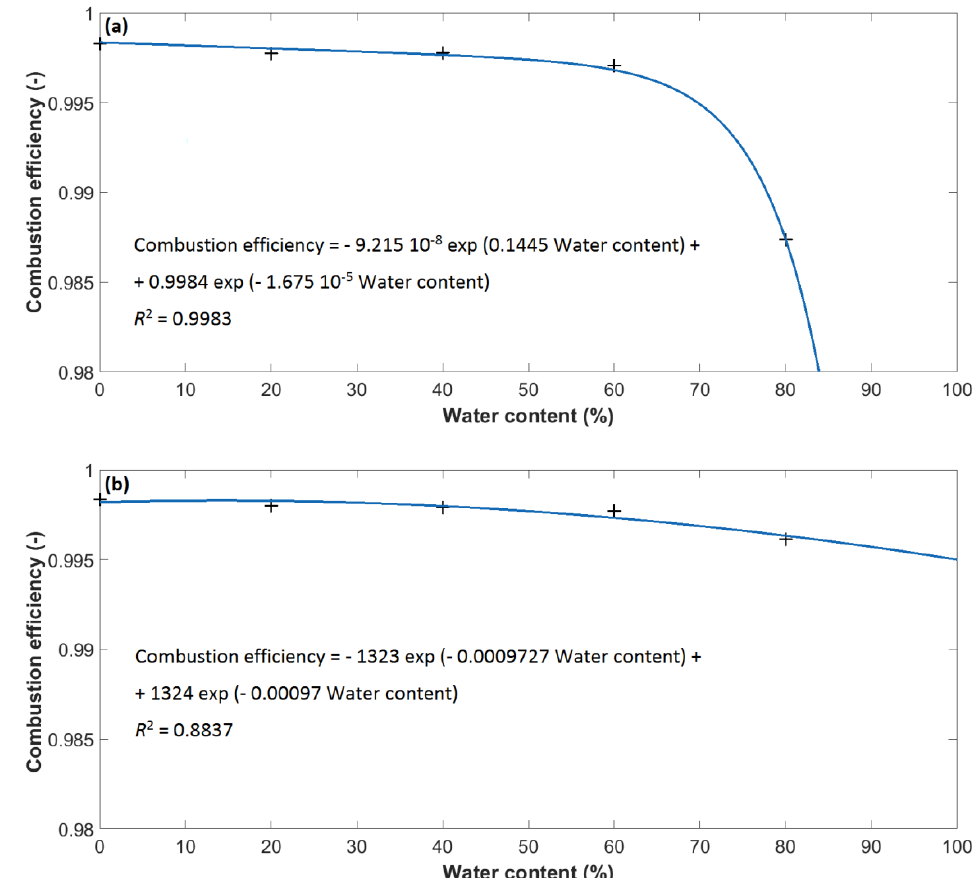
Figure 9. Dependency of the combustion e ffi ciency of investigated fuels on the water content: ( a ) Dependency of the combustion e ffi ciency of methanol on the water content; ( b ) Dependency of the combustion e ffi ciency of ethanol on the water content.